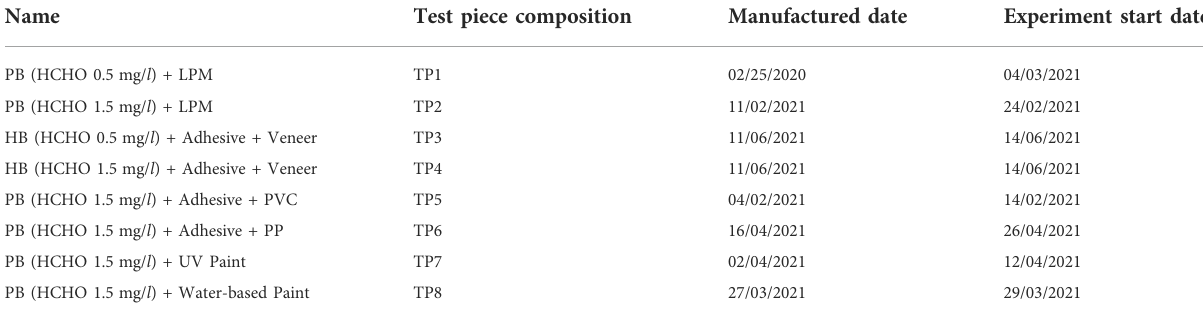
TABLE 3 Test piece composition and experiment start